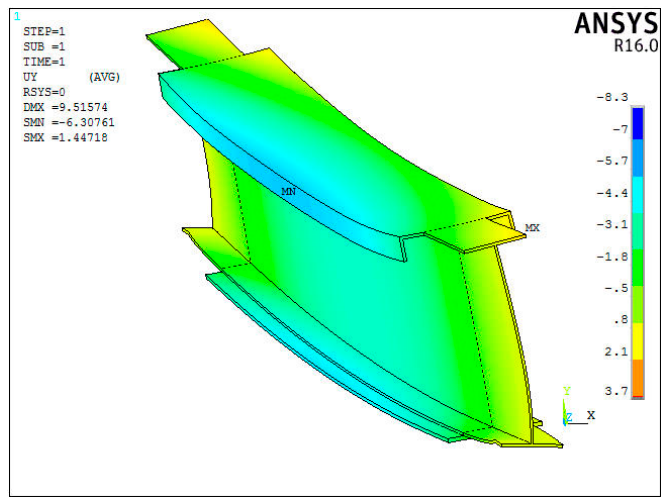
Figure 13. Distribution of the UY displacement.